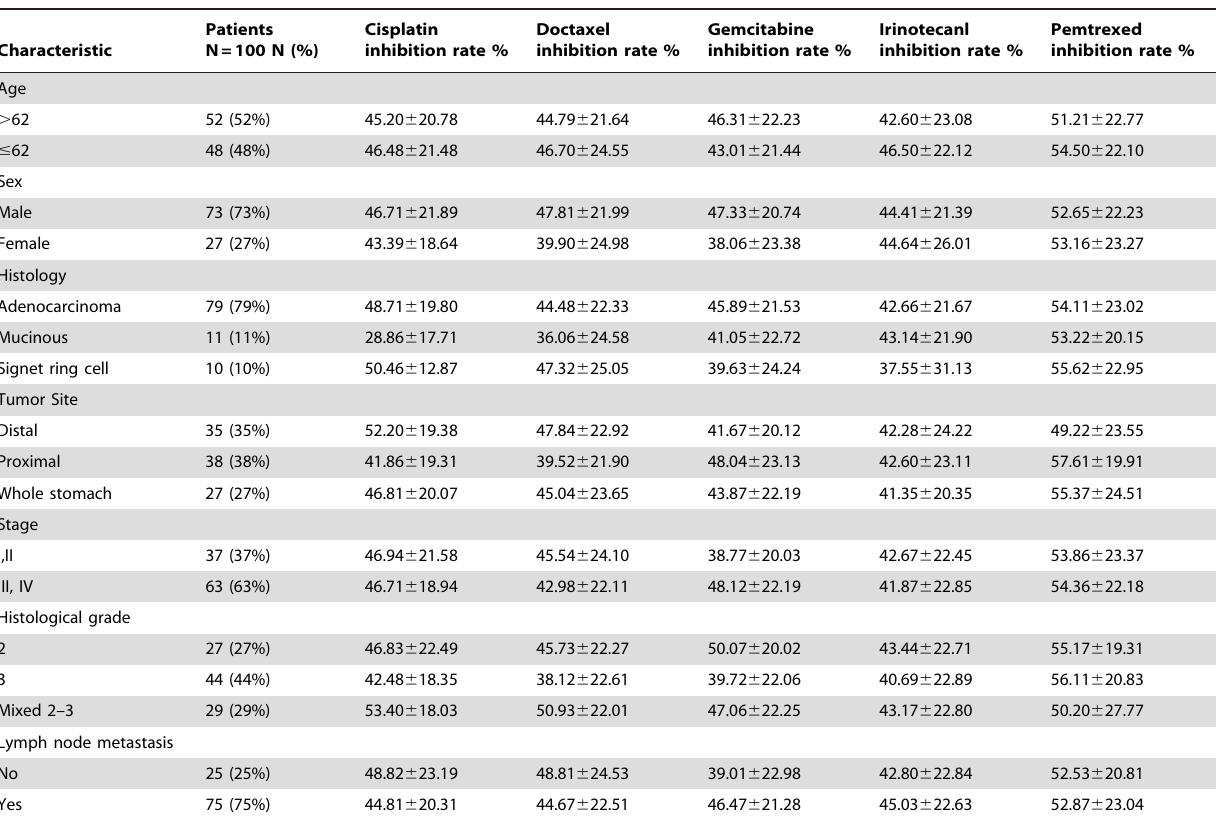
Data are expressed as mean 6 standard deviation.